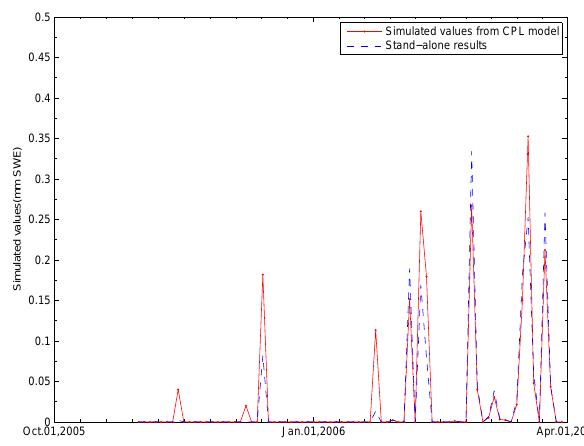
Fig. 2. Comparison of blowing snow sublimation from stand-alone blowing snow model (PIEKTUK-T) and coupled model (CPL) from 31 October 2005 to 30 April 2006 over SDNWA. Units in mm